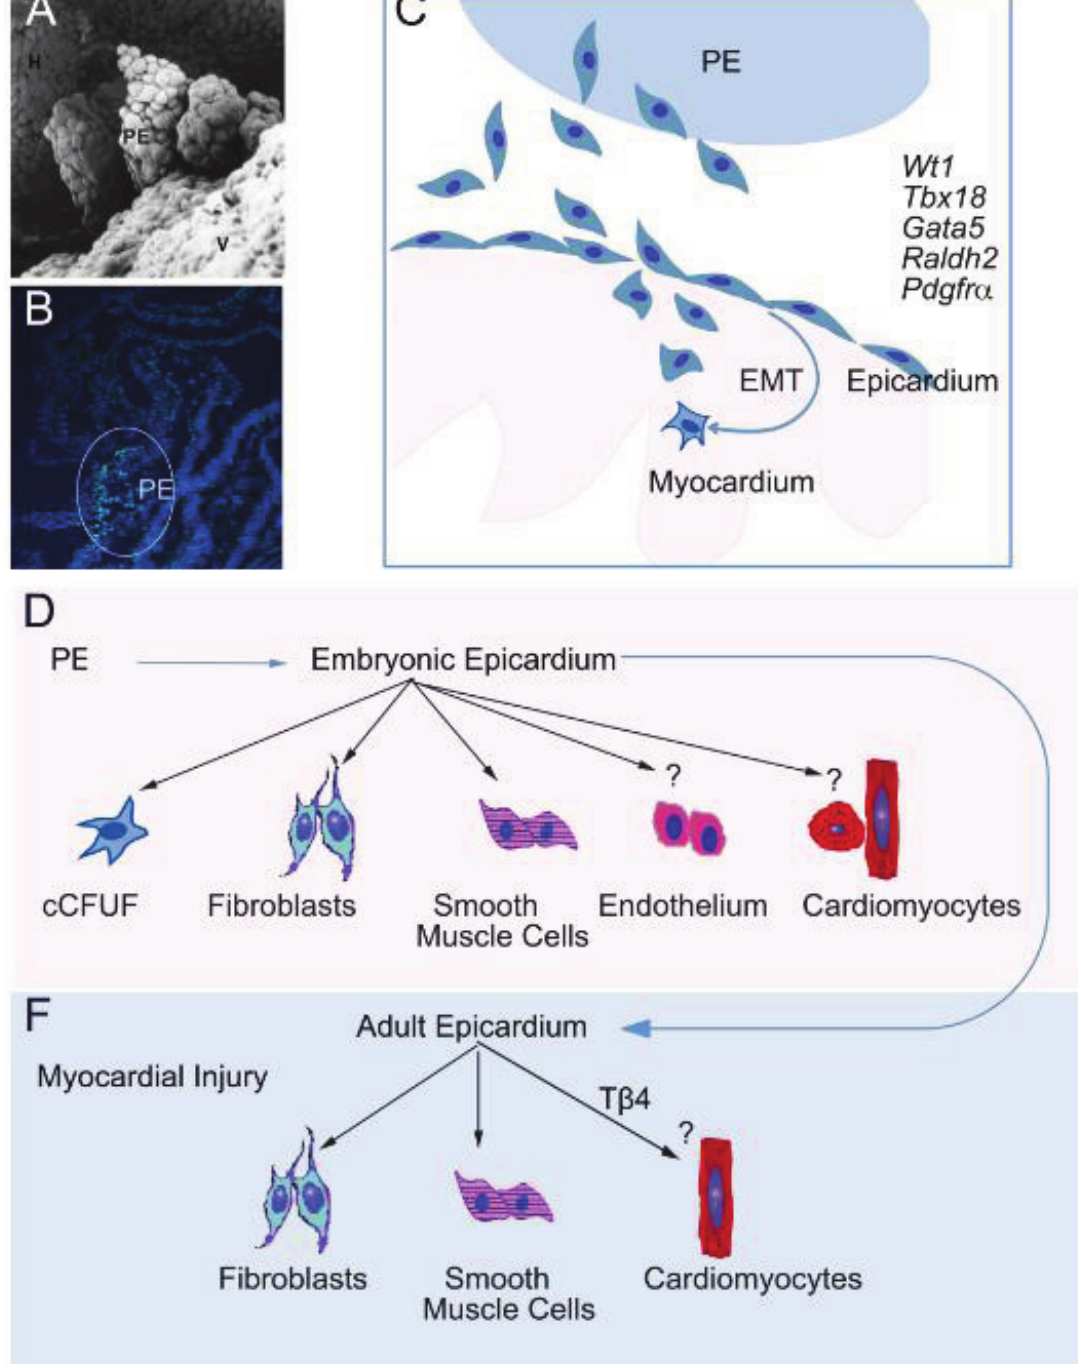
Figure 1. Structure and fate of the proepicardium. ( A ) The proepicardium (PE) of a quail embryo (stage HH21) as seen by scanning electron microscopy. The villous nature of the PE in the phase of adhesion to the ventricle (V), whilst still adjacent to the hepatic surface (H), is evident (courtesy of Dr. Ramon Muñoz Chapuli) [26]. ( B ) The PE is marked by immunofluorescence for LacZ expression in an E8.5 embryo derived from crossing Gata5- Cre × Z/EG reporter mice. ( C – F ) Schematic illustrations of PEO cell migration and differentiation in embryonic and adult hearts after myocardial injury. EMT, epithelial-to-mesenchymal transition; cCFU-F, cardiac colony forming